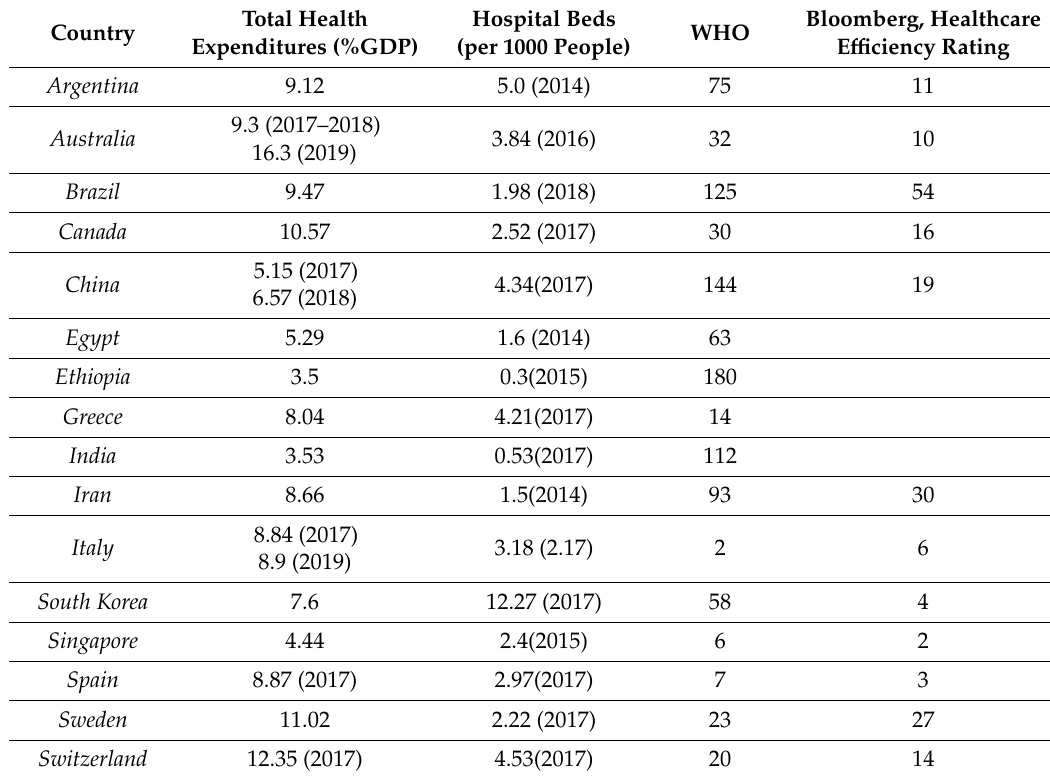
Table 1. Healthcare system